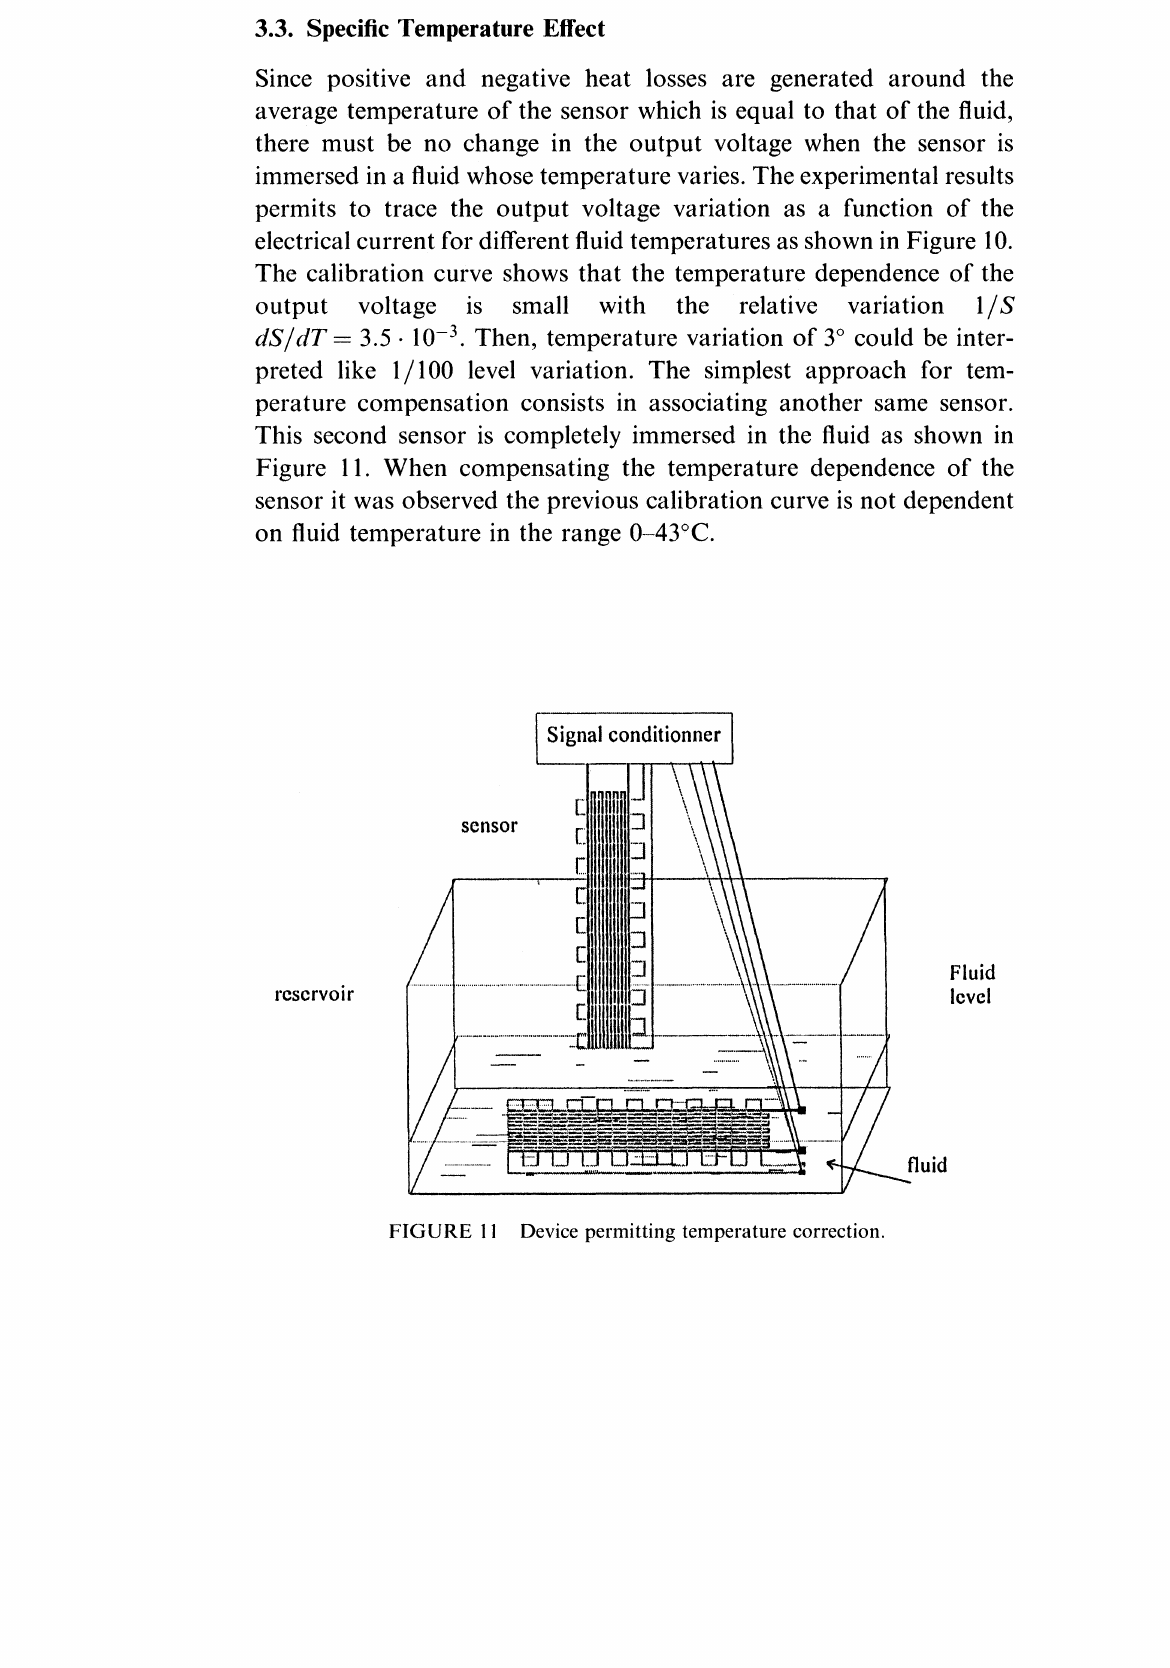
FIGURE Device permitting temperature